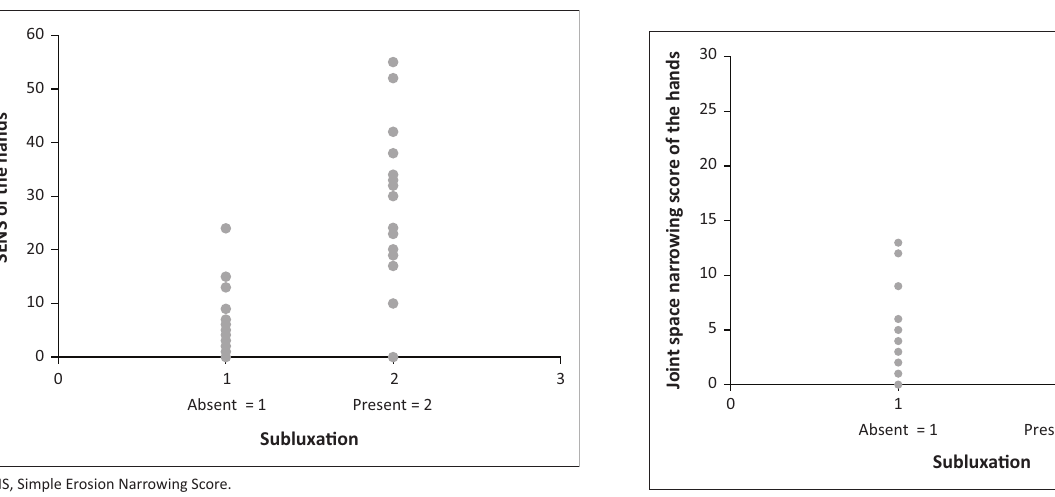
FIGURE 3: Correlation between the erosion score of the hands and the prevalence of cervical spine subluxation.